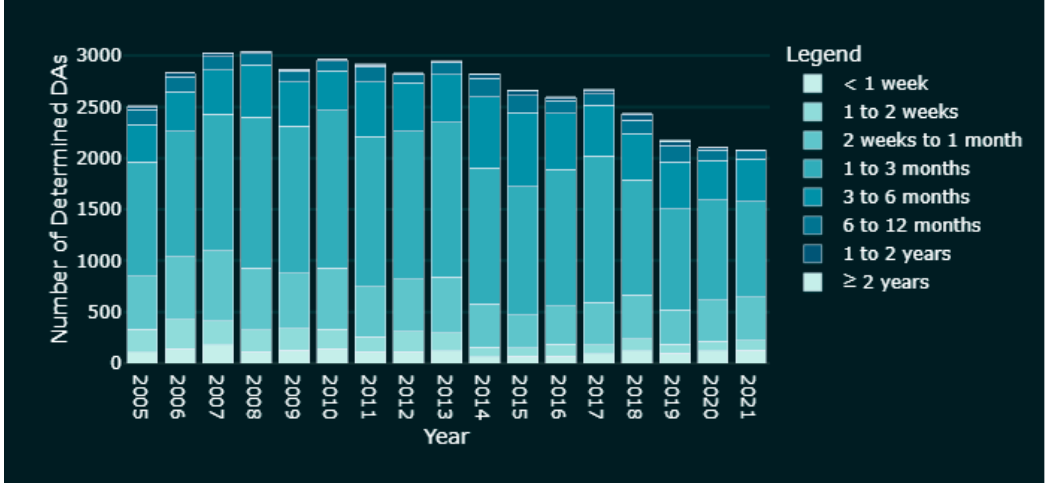
Figure 39. Assessment time distribution per year (2005–2021).